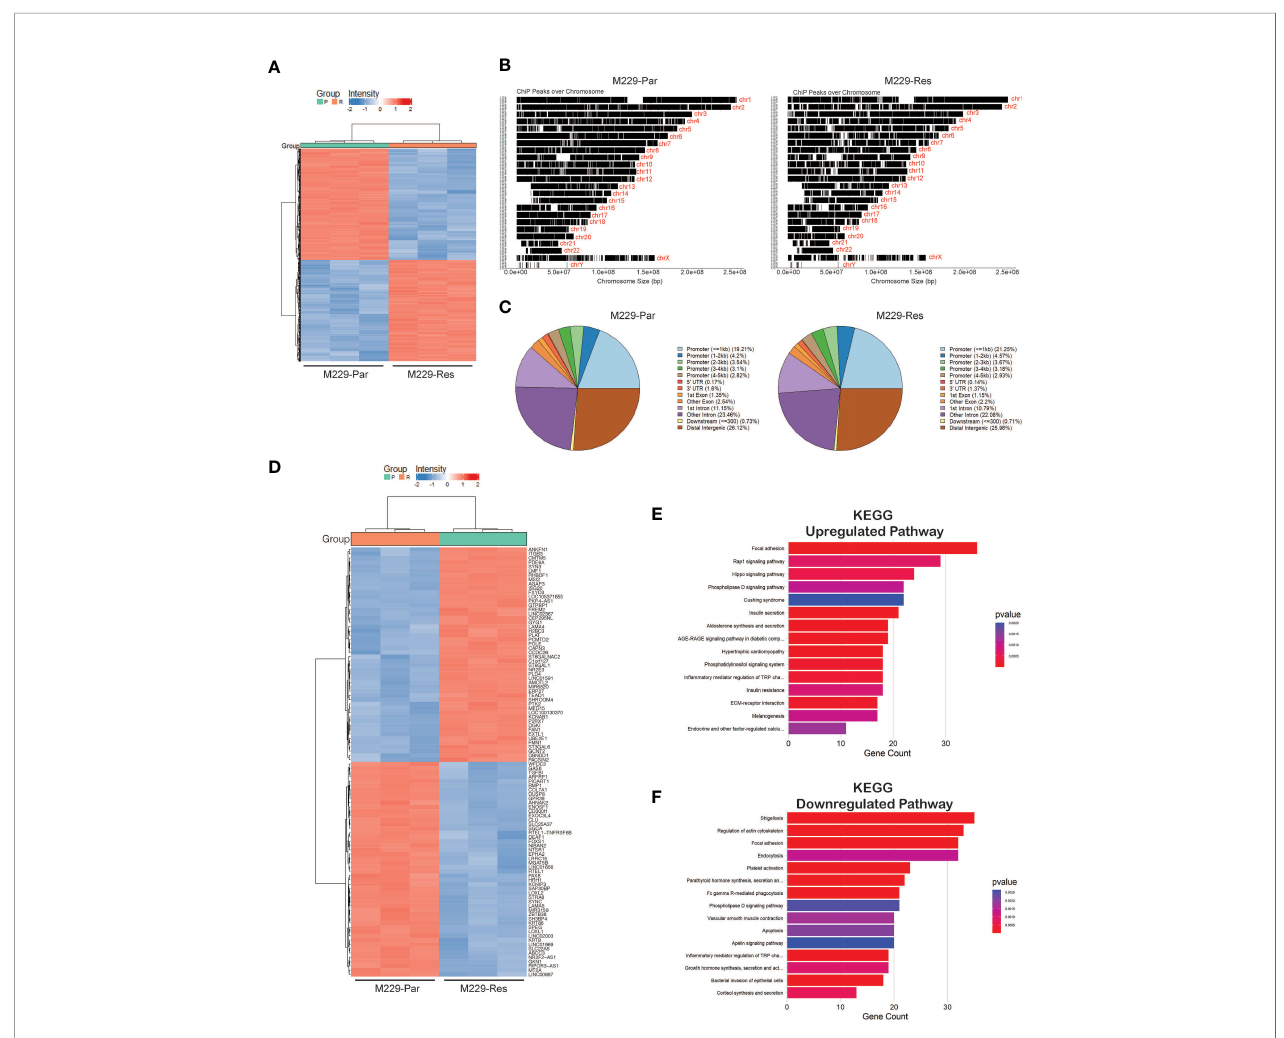
FIGURE 3 | ATAC-sequencing identi fi ed differentially expressed mRNAs between M229-Par and M229-Res cells. (A) Heatmaps showing differential genomic regions with increased or decreased chromatin accessibility based on ATAC-seq in M229-Res compared with M229-Par samples. (B) Chromatin-immunoprecipitation (ChiP) peaks over chromosomes analyzed by ATAC-seq in M229-Res and M229-Par samples. (C) Pie-chart for the indicated samples mapping the locations of annotated peaks identi fi ed by ATAC-seq. (D) Heat map showing the top 50 upregulated and the top 50 downregulated genes with increased and decreased chromatin accessibility based on p-values. (E, F) KEGG pathway analysis showing key upregulated (E) and downregulated (F) biological pathways associated with genes located in regions with increased or decreased chromatin accessibility in M229-Res cells compared with M229-Par